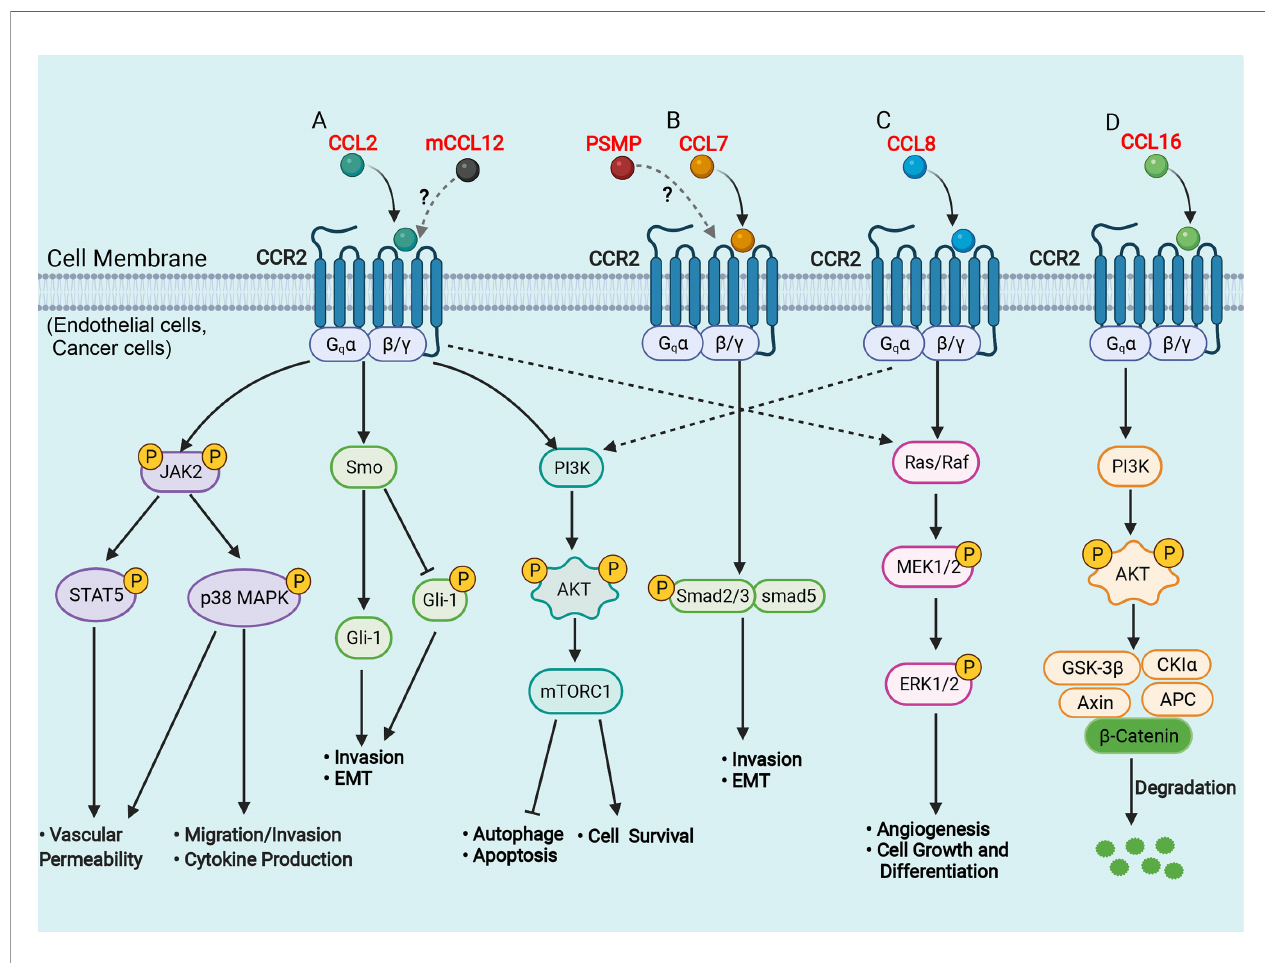
FIGURE 1 | Schematic representation of signaling pathways in the liver of CCR2 and its ligands. (A) CCL2 binds to CCR2 and activates JAK2, triggering several downstream pathways, such as STAT5 and p38MAPK, which enhance vascular permeability, promote cell migration and invasion, favor cytokine production; CCL2 binds to CCR2 and activates the Hh signaling pathway, and increases the expression of Smo and Gli-1, which induce cell invasion and EMT; CCL2 binds to CCR2 and activates the PI3K/Akt/mTORC1 pathway, promoting cell survival and inhibiting autophagosome formation and cell apoptosis. (B) CCL7 binds to CCR2 and activates the TGF- b /Smad signaling pathway, which promotes cell invasion and EMT; (C) CCL8 binds to CCR2 and activates the Ras/Raf/MEK/ERK pathway, enhancing cell growth and differentiation and promoting angiogenesis. (D) CCL16 binds to CCR2 and activates PI3K/AKT/GSK3 b signaling, which results in GSK3 b proteasomal degradation and enhances b -catenin stability. AKT, protein kinase B; APC, adenomatous polyposis coli; CK1, casein kinase 1; EMT, epithelial- mesenchymal transition; ERK, extracellular signal-regulated kinase; Hh, hedgehog; Gli, glioblastoma; GSK3 b , glycogen synthase kinase-3 beta; JAK2, Janus kinase 2; MAPK, mitogen-activated protein kinase; mTOR, mammalian target of rapamycin; MEK, mitogenic effector kinase; PI3K, phosphatidylinositol 3-kinase; Smo, smoothened; STAT, signal transducer and activator of transcription protein. (Figure created with